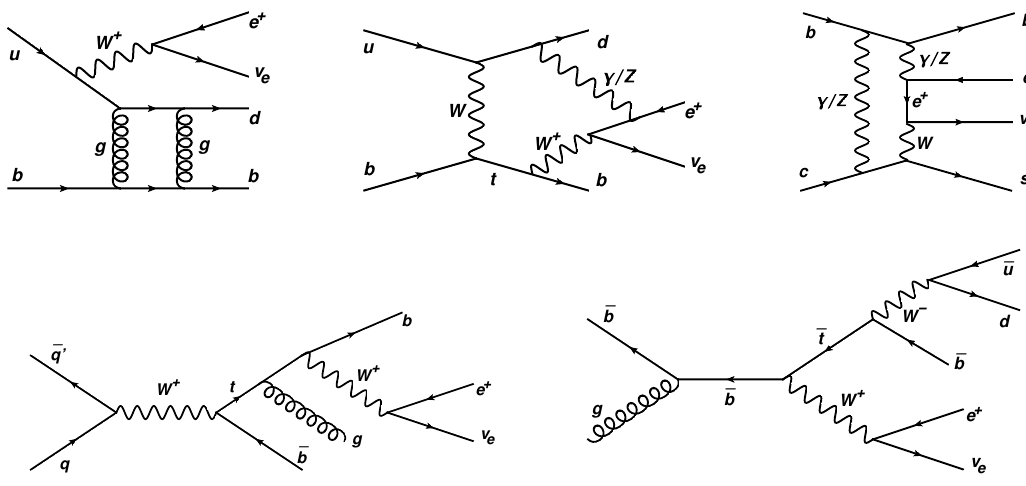
Figure 1 . Selection of Feynman diagrams contributing to the signature (2.1). The upper-left diagram contributes to NLO 1 and NLO 2 ( W +jets), the upper-central diagram to NLO 4 (single-top resonant), and the upper-right diagram also to NLO 4 (non-resonant). The lower-left diagram is a typical s -channel single-top production diagram, with an extra gluon, while the lower-right diagram can be considered (cid:22) tW + -associated production, both contributing to NLO 3